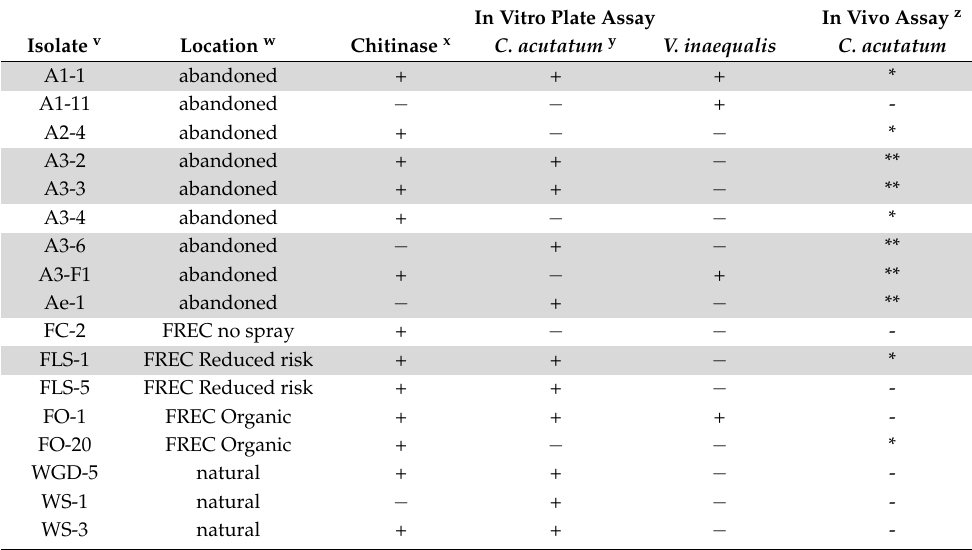
Table 1. Results from preliminary in vitro and in vivo screening of bacterial isolates collected from apples in Pennsylvania. Shaded isolates suppressed growth both in vitro and in